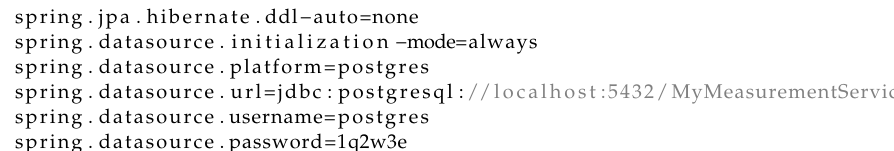
Figure 4. Importing existing MAVEN